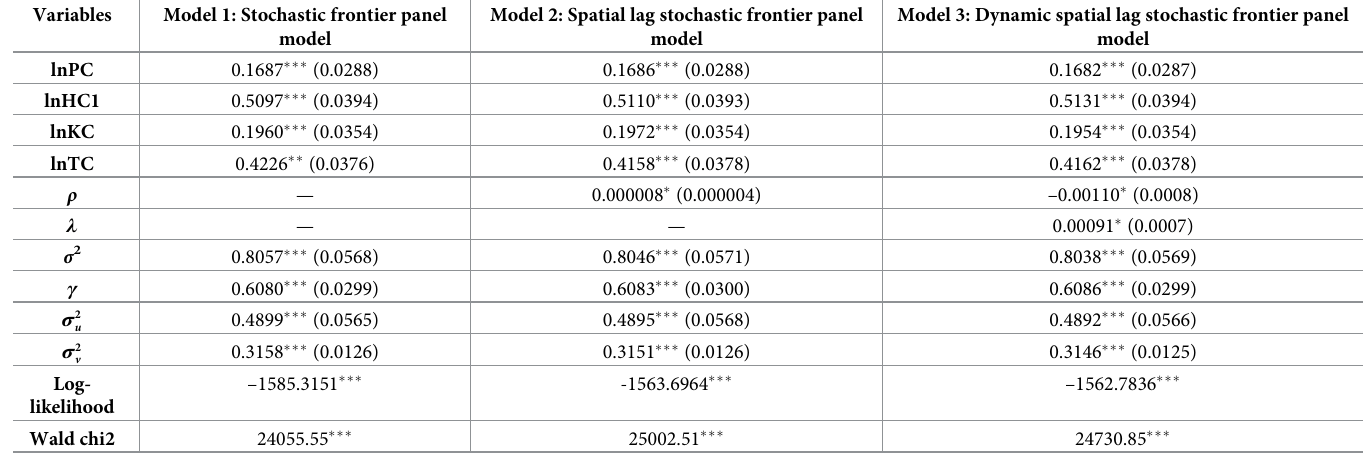
Table 6. Estimated results for robustness